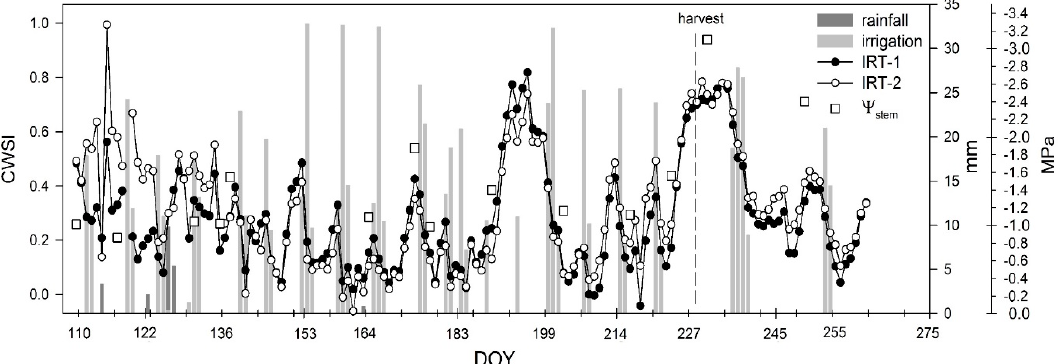
Figure 7. Seasonal evolution of the CWSI in mature almond trees, obtained by air and canopy temperature measurements at 14:00h. CWSI was calculated using the baselines shown in Figure 6.